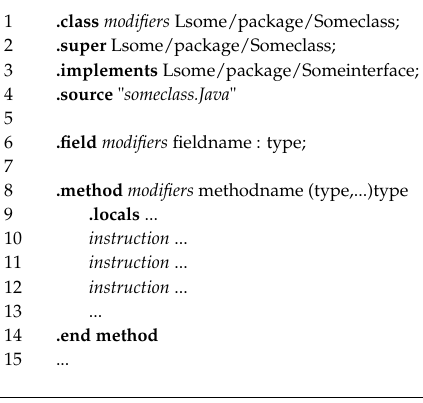
Figure 2. Structure of a Smali